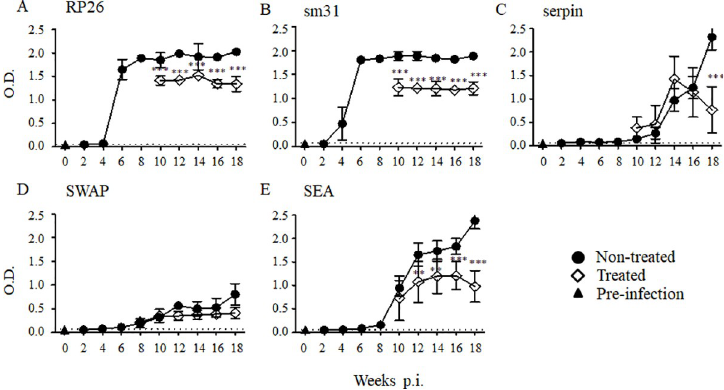
Fig 4. IgE responses to the S . mansoni antigens RP26, sm31, serpin, SEA and SWAP during S . mansoni infection and after the treatment. Five mice were infected with 50 S . mansoni cercariae, and the sera were collected from five mice at each time point. A group of mice was orally treated twice with 500 mg/kg PZQ at 8 weeks post-infection. The experiment was repeated for 3 times. The means of the IgE level to the S . mansoni recombinant RP26 (A), sm31 (B), serpin (C), and crude SWAP (D) and SEA (E) are shown with the standard errors. The dashed line represents the cut- off value (mean + 3SD of the OD of the pre-infected group). IgE levels of the treated group (open diamonds) were compared with those of the untreated group (closed circles) and with those of pre-infection samples taken at week 0 (closed triangles). �� p < 0.01 and ��� p <